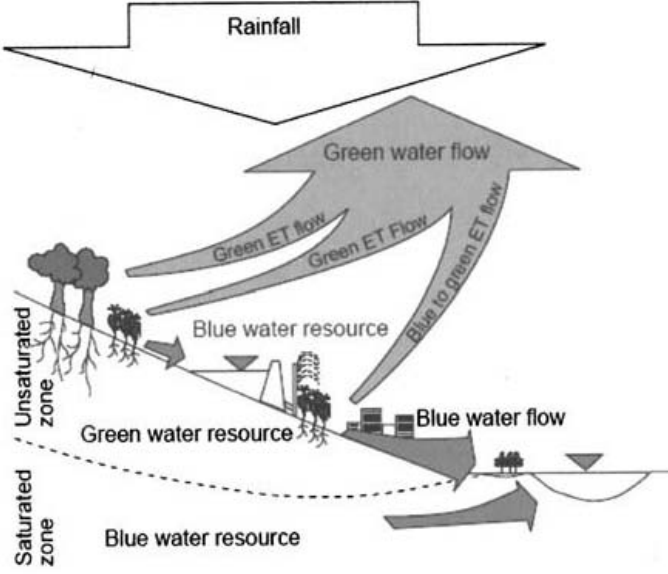
Figure 13. Blue water-green water approach [91]. About 20% of all water used for crops comes from the blue water diversions (from water in lakes, reservoirs, rivers, and ground water in aquifers) irrigating 278–399 Mha (without intensity) and 467 Mha (with intensity) annually. There is an additional 10% of water from direct rainfall (green water) over irrigated croplands. The rest, about 70%, of water used by crops is the green water (water in soil moisture in unsaturated zone) used by about 1.13 billion hectares of rainfed croplands. Management strategies for blue and green water are not the same and the impacts on food security depend synergistically on how blue and green water is managed and for what crops and where.